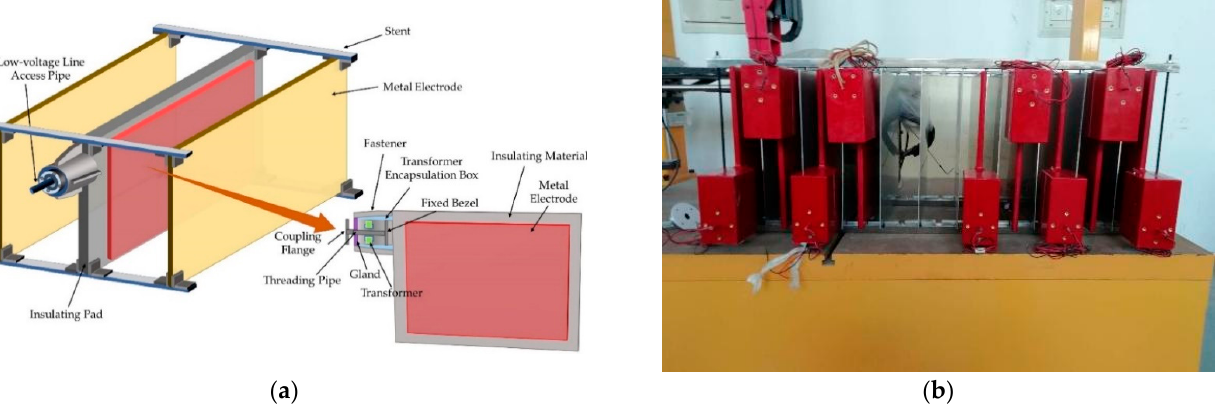
Figure 6. ( a ) Schematic diagram of the built-in electrode assembly and a close-up of insulated electrode structure; ( b ) the actual appearance of the alternating metallic and insulating electrodes.